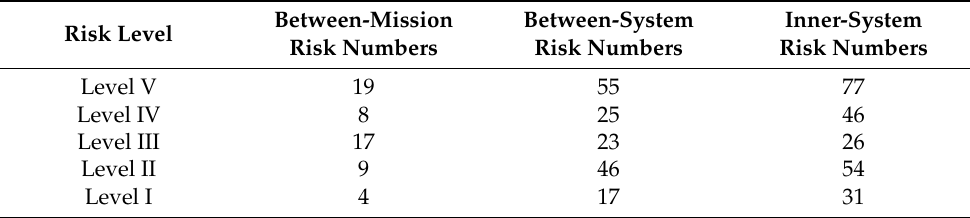
Table 4. Multi-layer configuration risks synthetically evaluation